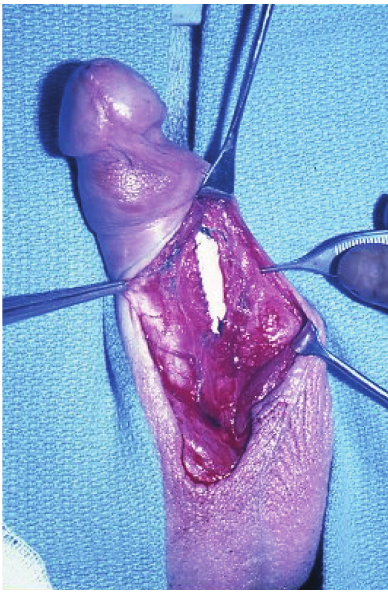
Figure 1: Augmentation of the tunica albuginea is shown here with a rectus fascia graft sewn in place allowing coverage of the penile